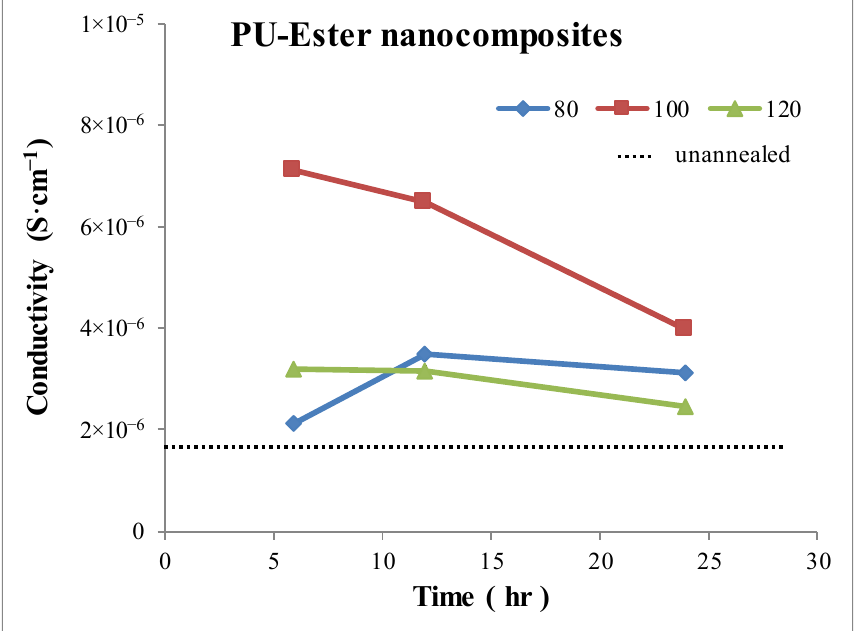
Figure 7 . Conductivities of PU - Ester / MWCNT nanocomposites with various annealing conditions .